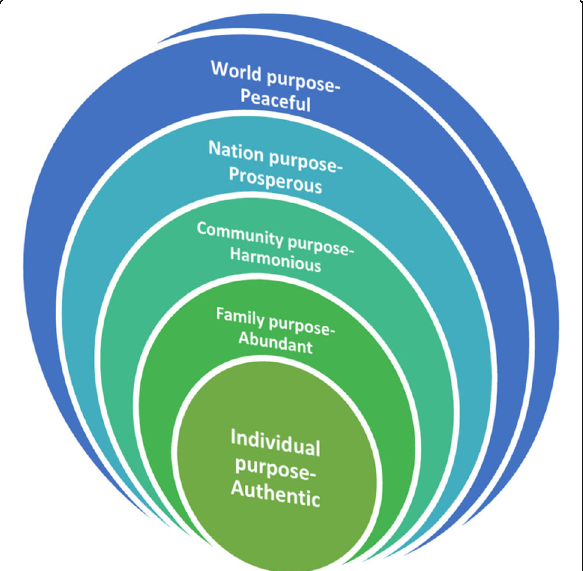
Fig. 4 The Five Waves of Virtue or Purpose of Authentic